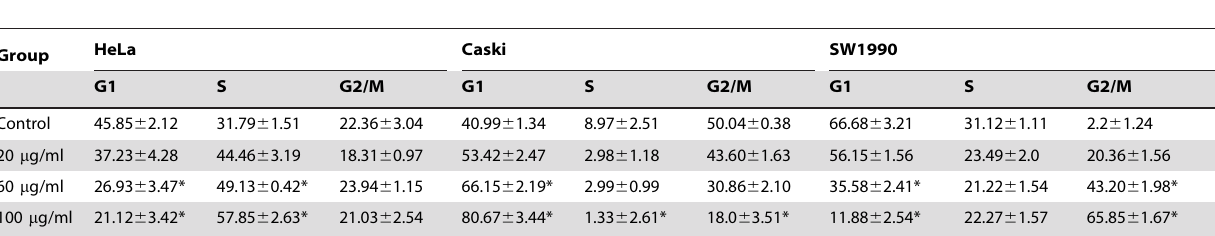
Table 2. Cell cycle effects of TCS on cancer cells. n = 3, Mean 6 SD.